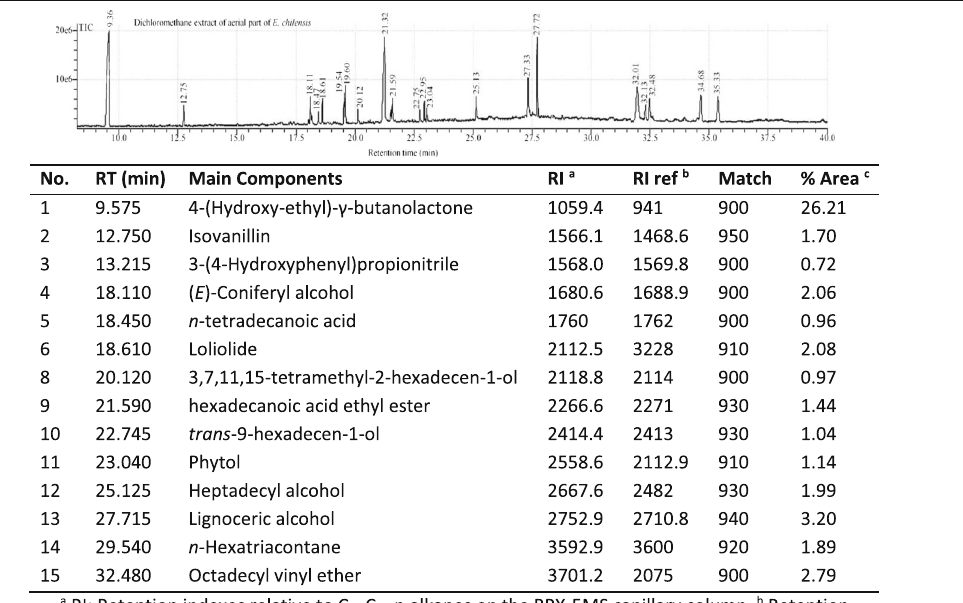
Table 8 GC-MS analysis for the CH 2 Cl 2